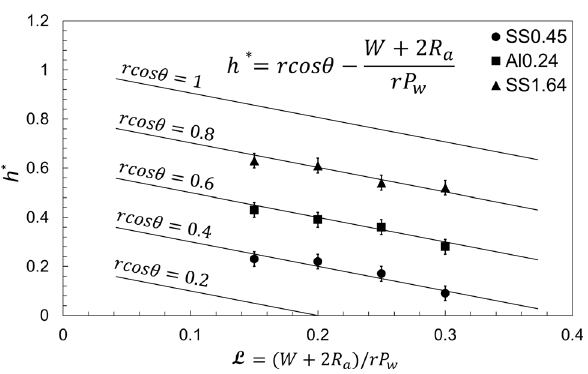
Figure 15. The unifying non-dimensional form of capillary height, Eq. (17), as a function of the characteristic length scale, contact angle, and surface roughness, as compared to our experimental data.